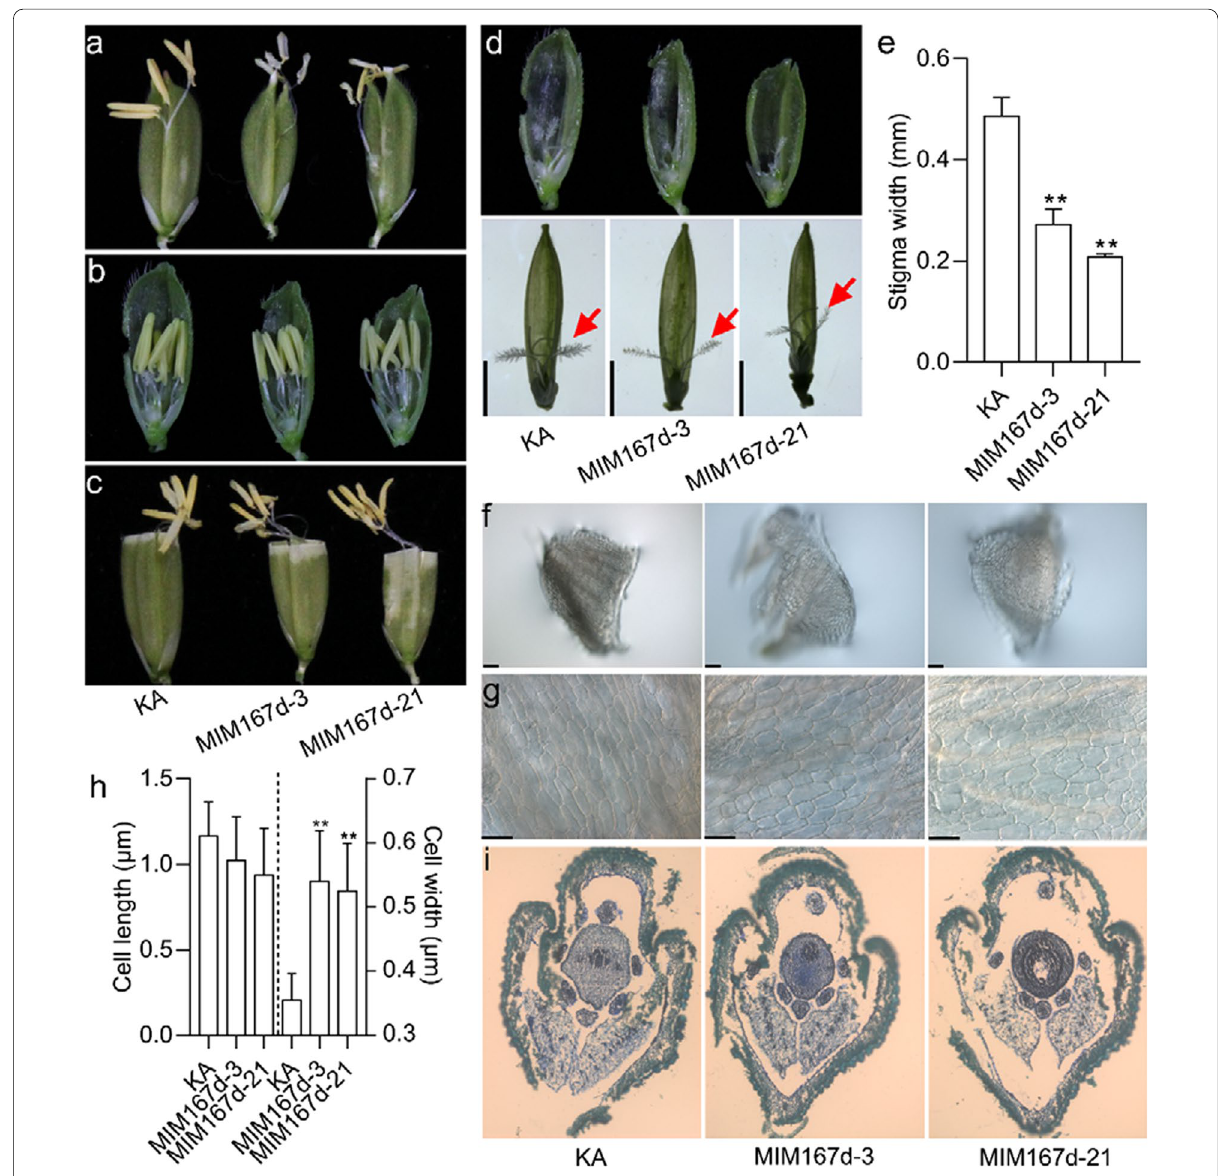
Fig. 3 Phenotypic analysis of the floral organs in MIM167d. a Phenotype of the flowers. The anthers from KA and MIM167d move out from the flowers. b Overview of the inner floral organs in KA and MIM167d lines. c Phenotype of the filament elongation. d Phenotype of the stigmas. The stamen was removed from ( b ). Red arrows indicate the stigmas. Bars, 2 mm. e Comparison of the stigma width. Error bars indicate the standard deviation (SD) (n 10). **P < 0.01 (Student’s t ‑test). f Close‑up view of the lodicules in KA and MIM167d. Bars, 100 μm. g Cell morphological features = of lodicules in KA and MIM167d. Bars, 50 μm. h Comparison of the cell length and cell width from ( g ). Error bars indicate the standard deviation (SD) (n 20). **P < 0.01 (Student’s t ‑test). ( i ) Transverse sections of flower in KA and =